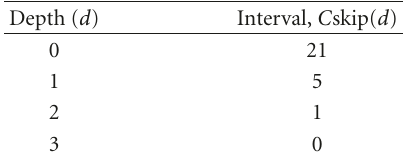
Table 1: Interval values of every depth C skip( d ), where Cm = 4, Rm = 4, and Lm =